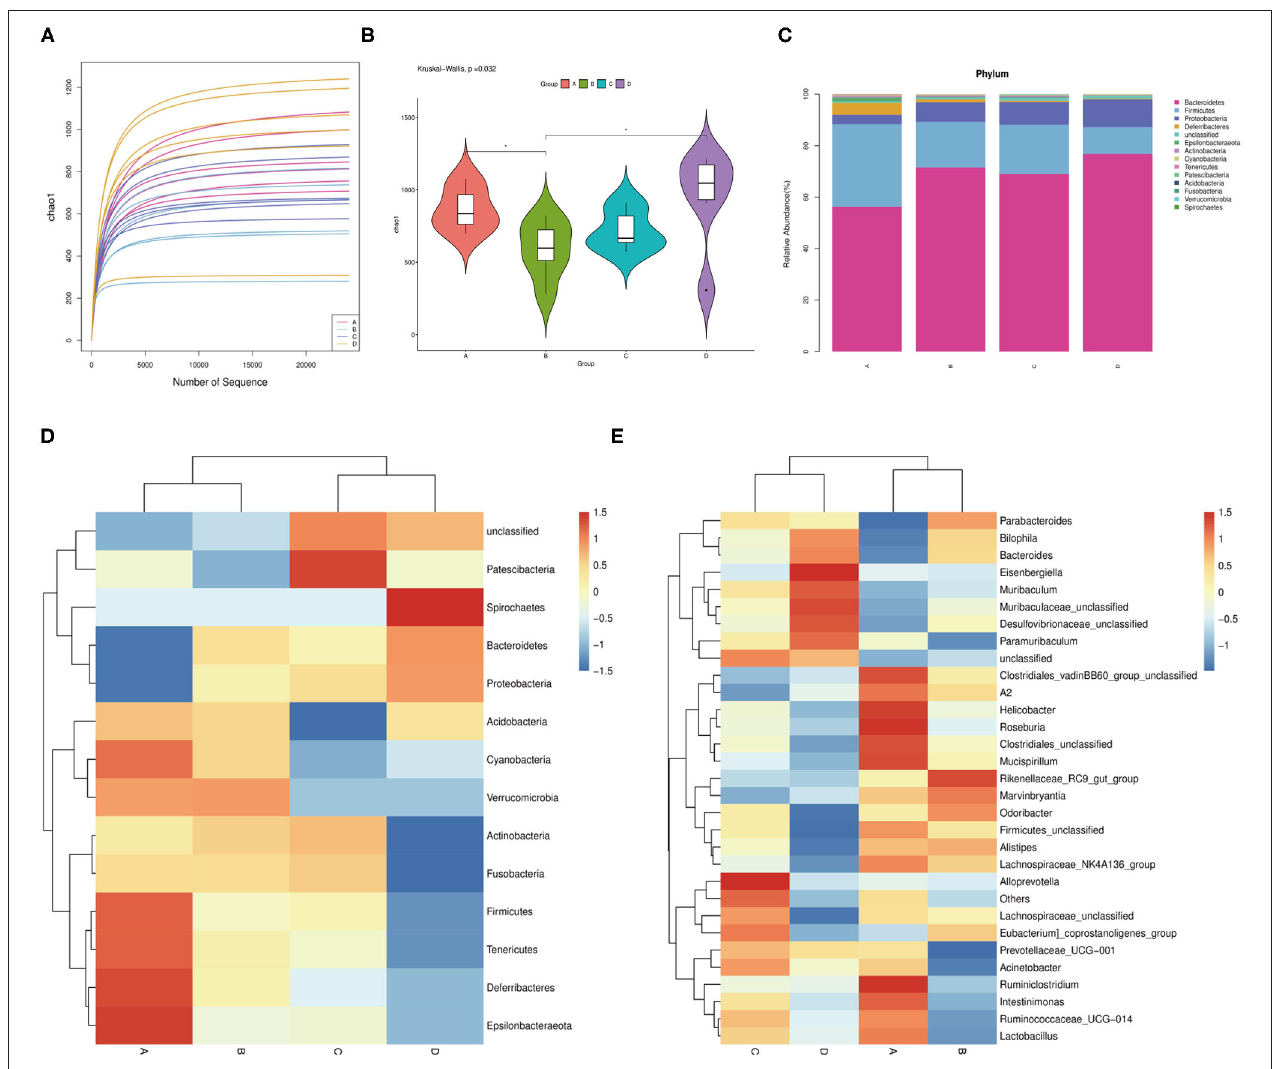
FIGURE 4 | Microbial community changes in the colon content of mice after probiotic administration. (A) Bacterial rarefaction curves for assessing the sequencing depth of each sample. (B) Alpha diversities in bacterial communities as determined by Chao1 index. (C) Average relative abundances of taxa at the phylum level. (D) Heat map and hierarchical clustering of phylum in the intestinal bacterial communities of mice. (E) Clustering heat map analysis of bacterial genera at the genus level. (A) JT3-1 group, (B) FBL-3a group, (C) ZLP-4b group, and (D) control